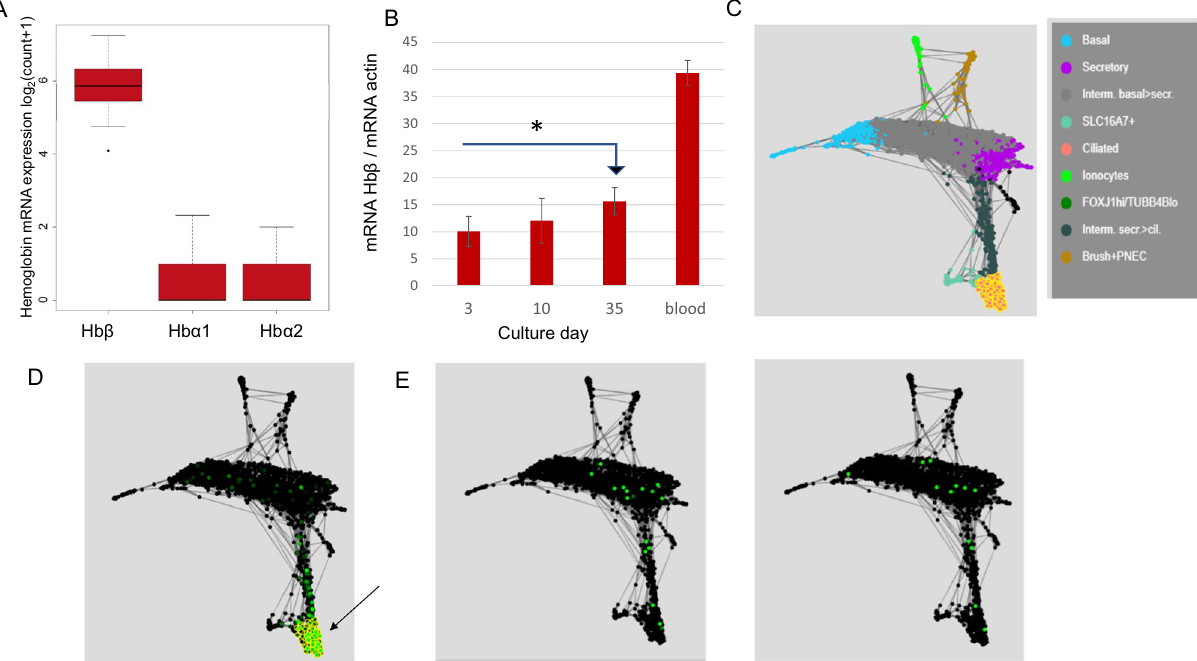
Figure 1. Hemoglobin RNA is expressed in human airway epithelium and increases during maturation to fully ciliated epithelium. ( A ) Box and whisker plots show hemoglobin β (Hbβ), hemoglobin α1 (Hbα1) and hemoglobin α2 (Hbα2) gene expression data (log2 transformed) of 48 samples collected from six healthy donors (GEO database 11 : https:// www. ncbi. nlm. nih. gov/ geo/ query/ acc. cgi? acc= GSE97 036). * p < 0.001. Box and whisker plots were created using R Software: R Core Team, 2021. R: A language and environment for statistical computing. R Foundation for Statistical Computing, Vienna, Austria. URL https:// www.R- proje ct. org/. ( B ) Reverse transcription polymerase chain reaction (RT-PCR) analysis of Hbβ expression normalized to actin levels in primary normal human airway epithelial cell ALI cultures at days 3, 10, and 35; mRNA Hbβ obtained from human blood was a control (n = 6, * p ≤ 0.0047). ( C ) SPRING plot from publicly available single cell gene cluster analysis of human bronchial epithelial cell ALI cultures 12 . Each dot is a single cell. Blue-basal cells, purple-secretory, green-ionocytes, brown-brush + neuroendocrine cells, yellow-orange-ciliated cells. ( D ) Hbβ gene expression in primary human bronchial epithelial cells 12 . Each dot is a single cell. The distribution of Hbβ in HBEC: Hbβ (green) is predominantly localized in ciliated cells; that is, it has the same distribution as the yellow-orange cells in ( C ). Arrow points to Hbβ in ciliated epithelium. The SPRING plot is queried for Hbβ ( HBB ) mRNA. ( E ) Hemoglobin α1 and α2 gene expression in primary human bronchial epithelial cells. There is less Hbα1 and Hbα2 (green) HBEC: Hbα1 (left, green) and Hbα2 (right, green), and they are not localized to ciliated cells. The SPRING plot is queried for Hbα1 and Hbα2 ( HBA1 and HBA2 )